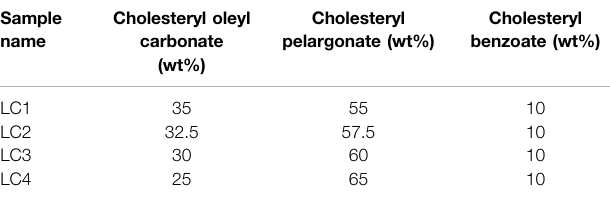
Frontiers in Bioengineering and Biotechnology |